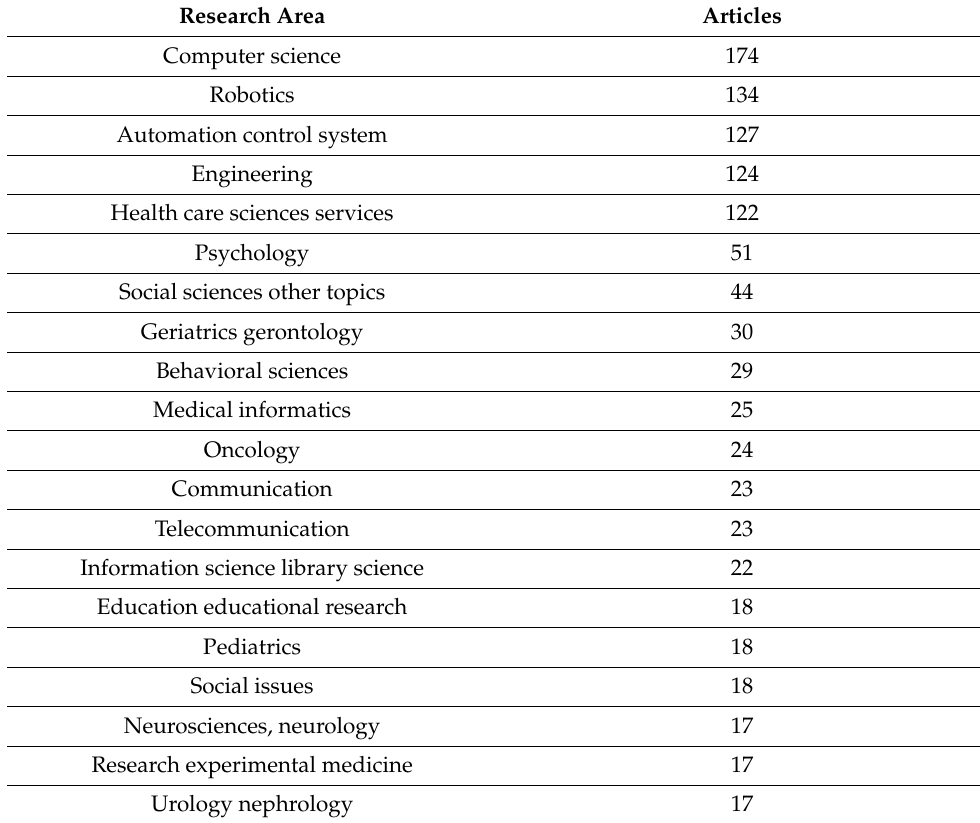
Table 2. Search results by research